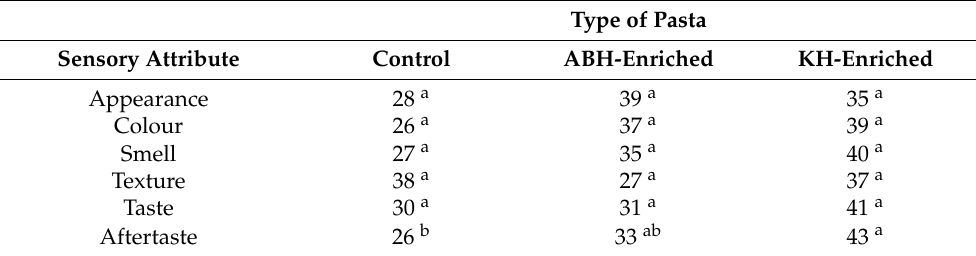
Table 5. Sensory ranking test score (sums of 17 semi-trained consumers) of GF fresh pasta enriched with 8 g/100 g of Apulian black (ABH) or kabuli (KH) chickpea hulls, compared to control pasta. Type of Pasta Sensory Attribute Control ABH-Enriched KH-Enriched Appearance 28 a 39 a 35 a Colour 26 a 37 a 39 a Smell 27 a 35 a 40 a Texture 38 a 27 a 37 a Taste 30 a 31 a 41 a